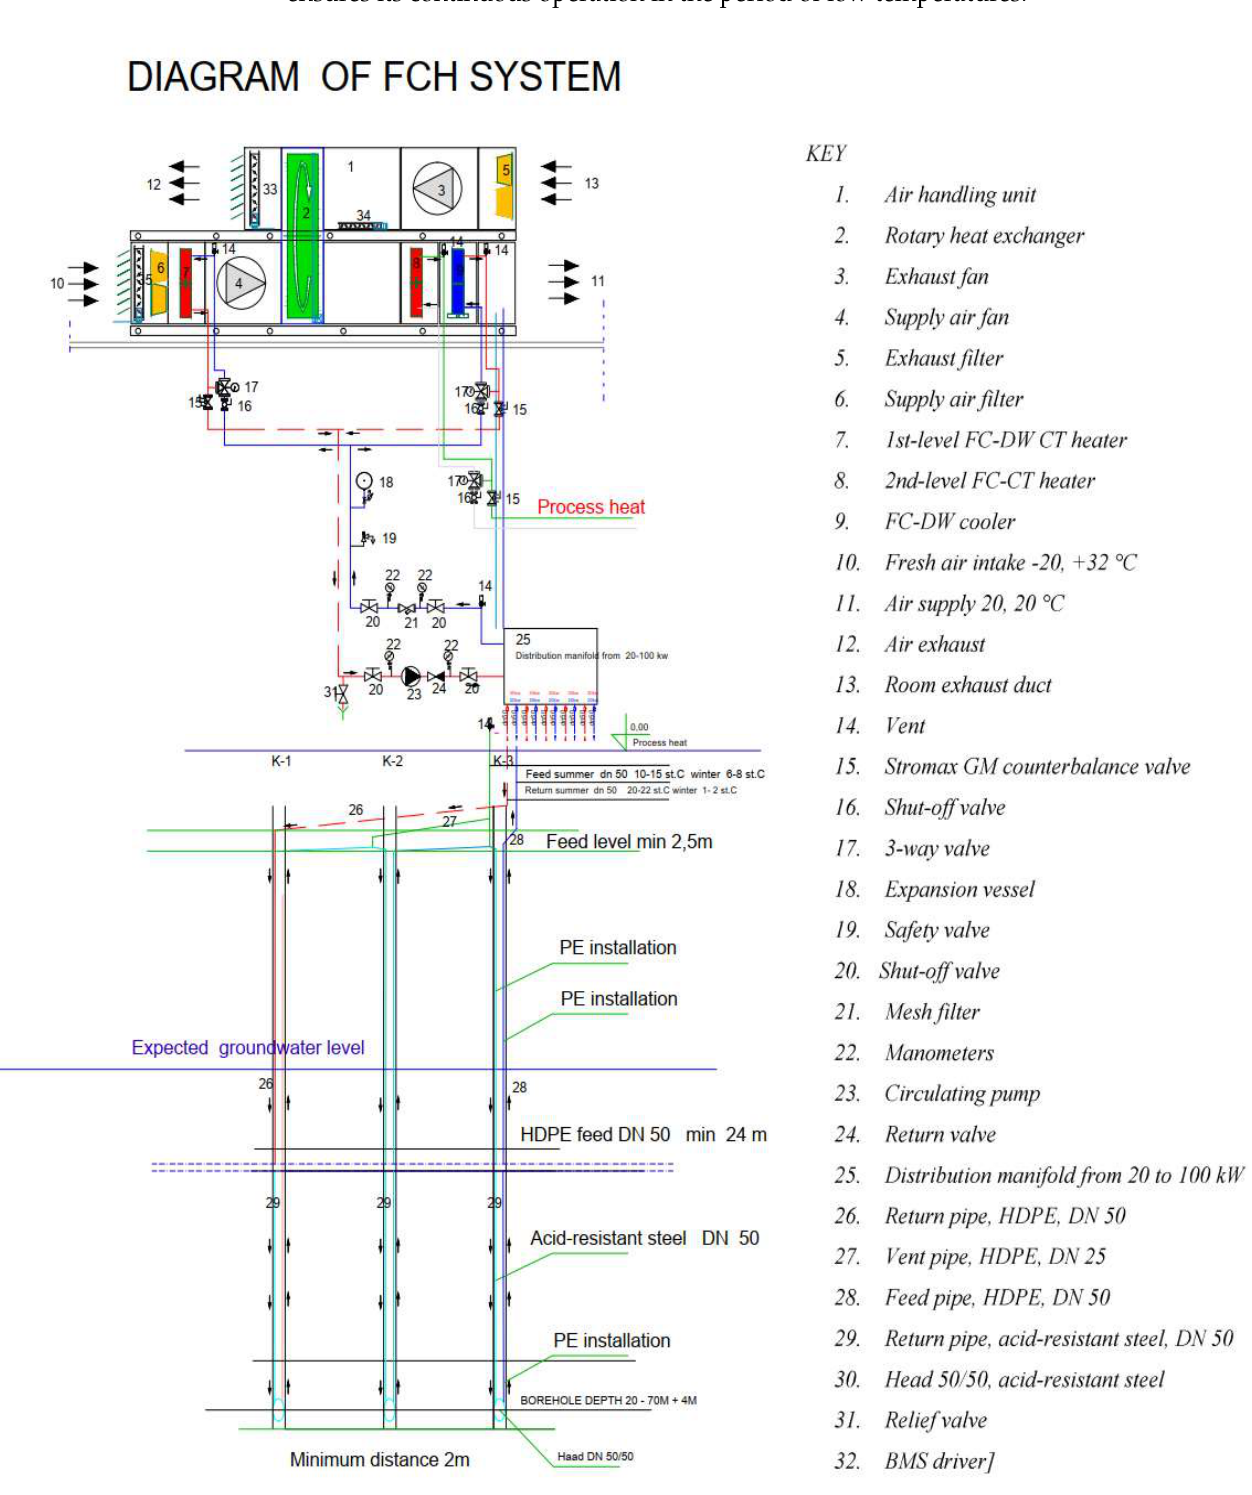
Figure 2. A view of the FCH HVAC technology in the area below the ground level, in which the energy obtained from groundwater is transferred to the FCH system.